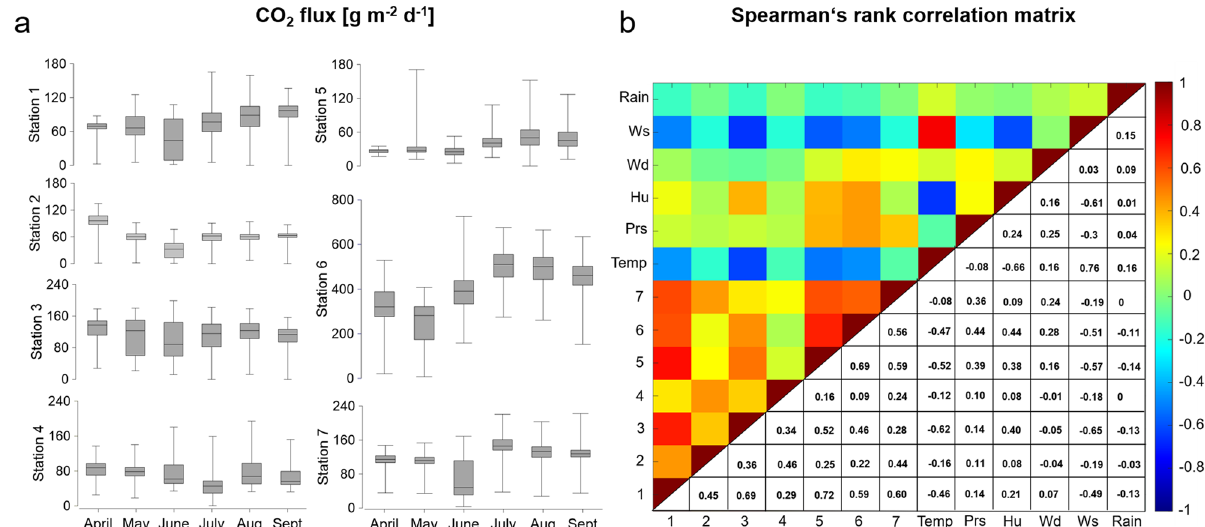
Figure 3. ( a ) Boxplots showing the variability of CO 2 flux values during the monitoring period. ( b ) Spearman correlation coefficients showing the relationship between stations and atmospheric parameters. The y-axis labels are defined as follows: Temp air temperature, Prs barometric pressure, Hu air humidity, Wd wind direction, Ws wind speed,